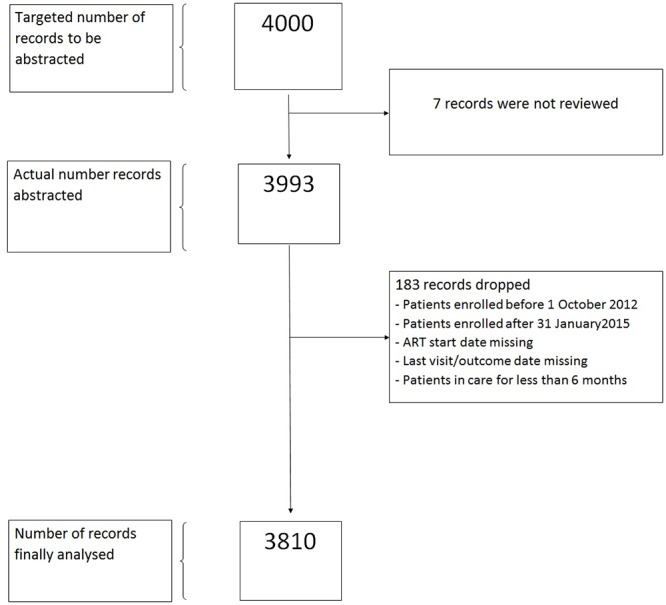
Study population.